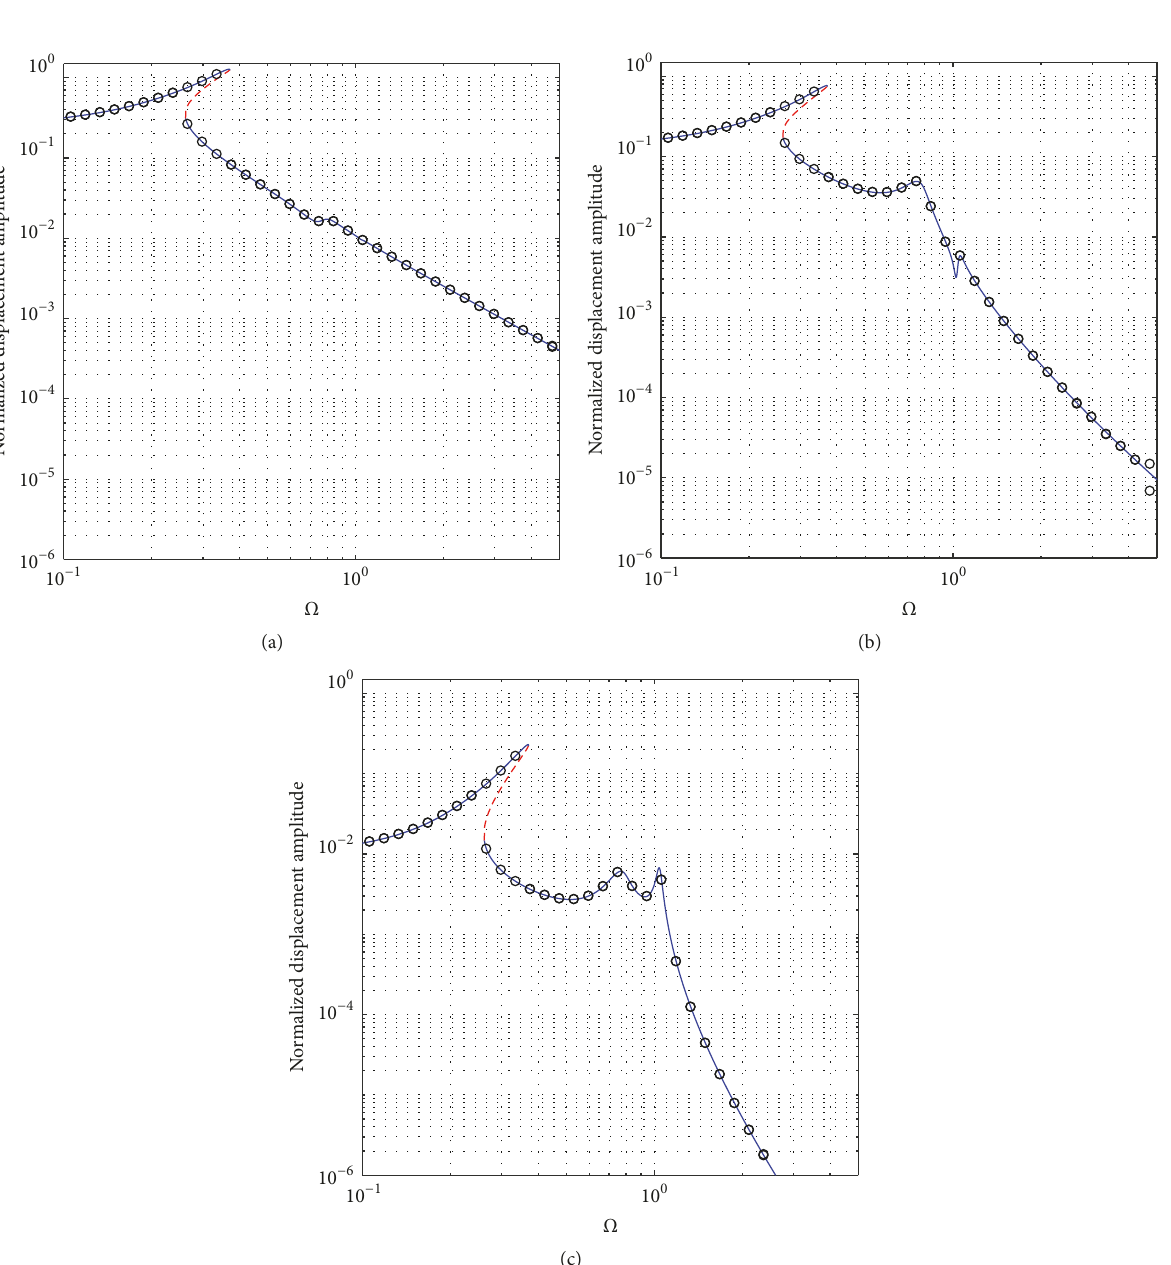
𝑚 s . HBM solution: